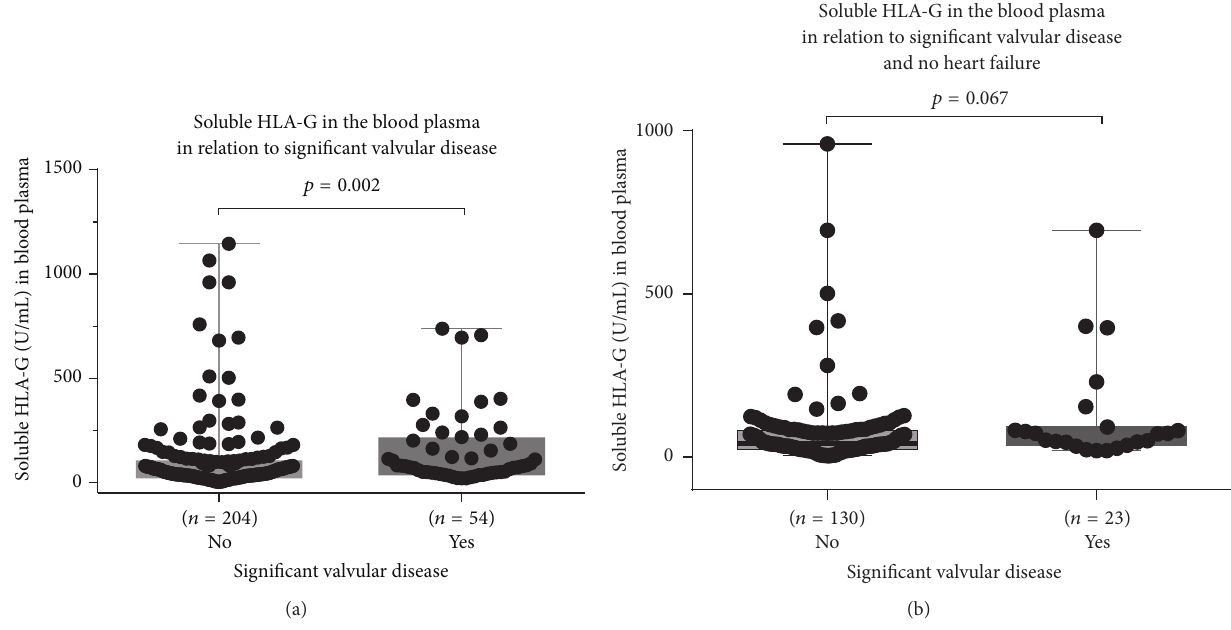
Figure 5: (a) Soluble HLA-G in peripheral blood in relation to significant valvular heart disease (box and whiskers plot, min. to max., all points shown; 𝑝 = 0.002 , Mann–Whitney test). (b) Soluble HLA-G in peripheral blood in relation to significant valvular heart disease in patients without heart failure (EF > 50%) (box and whiskers plot, min. to max., all points shown; 𝑝 = 0.067 , Mann–Whitney